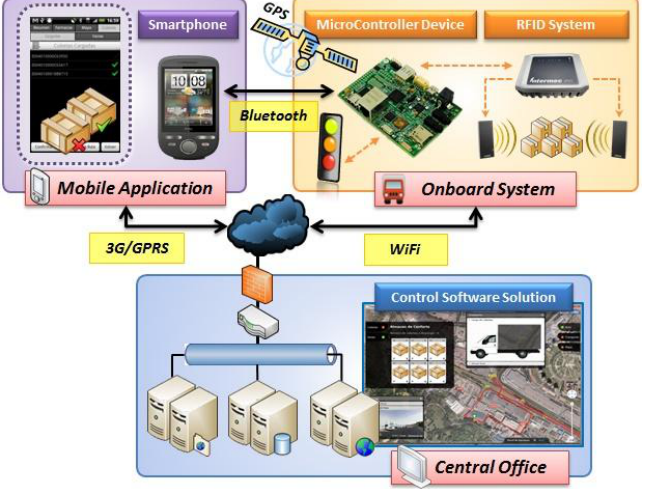
Figure 9. Description of the system architecture and possible